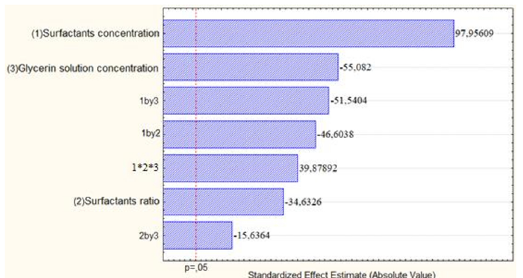
Figure 2. Pareto